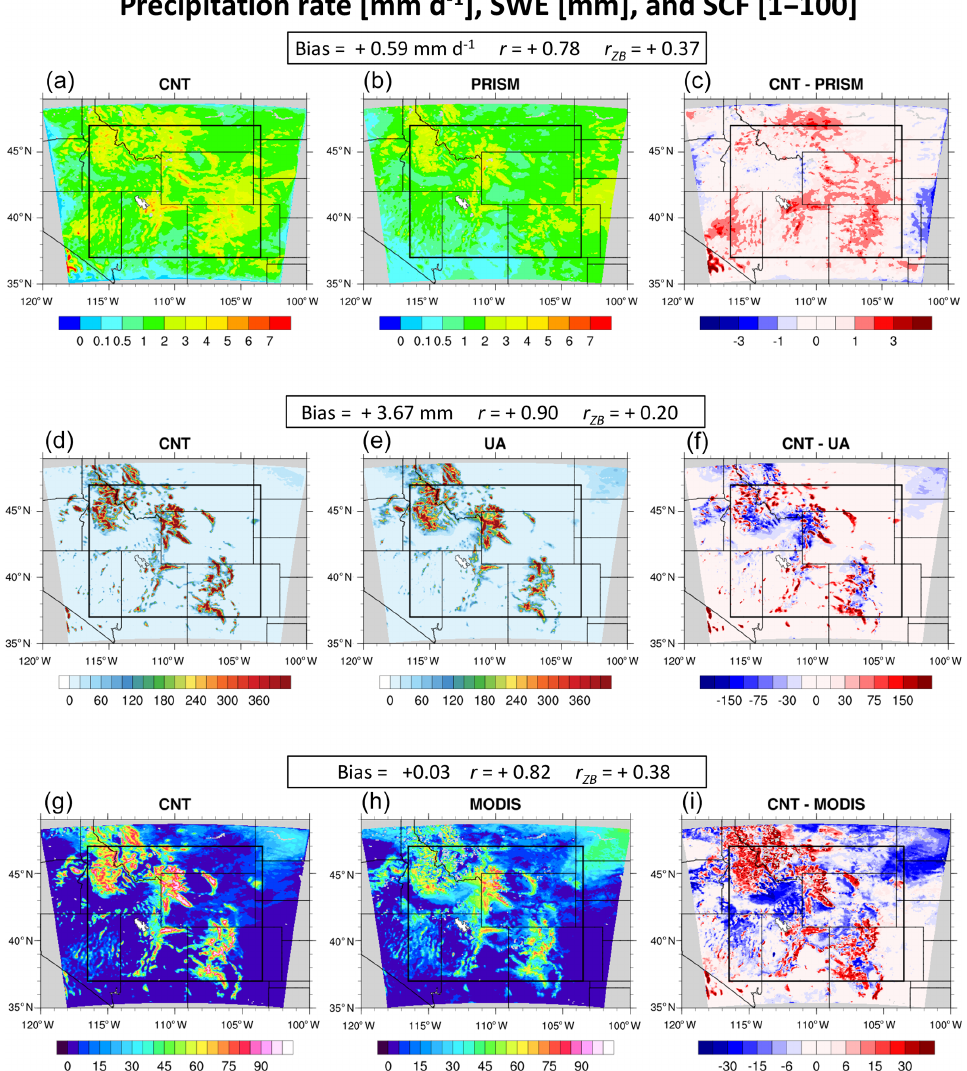
Figure 4. As in Fig. 3, but precipitation rate is compared to PRISM (a, b, c) , SWE is compared to UA (d, e, f) , and SCF is compared to MODIS (g, h, i)